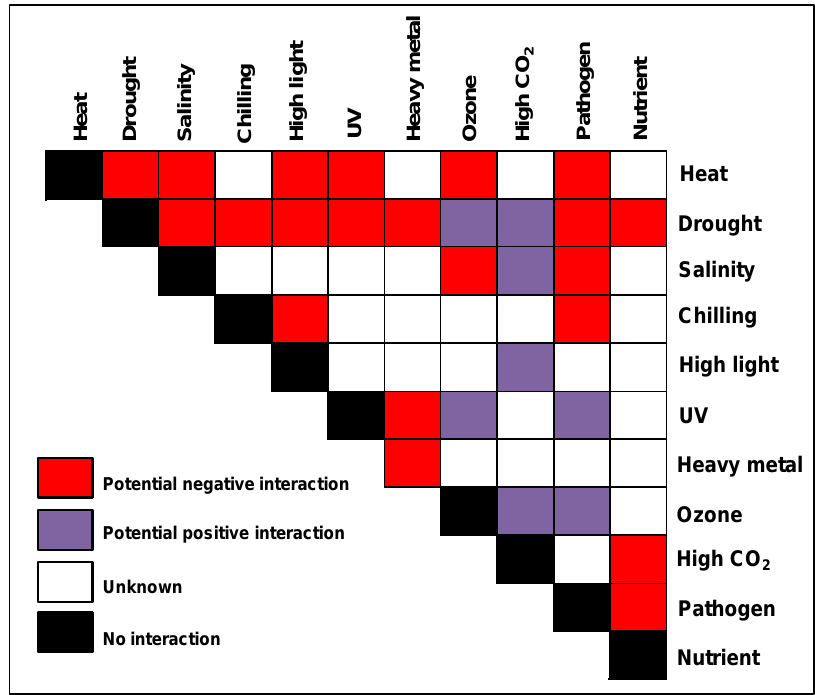
Figure 1. The stress matrix. Different combinations of potential environmental stresses that can affect crops in the field are shown in the form of a matrix. The color of the matrix indicates stress combinations that were studied with a range of crops and their overall effect on plant growth and yield. References for the combined studies are given in the Table 2.